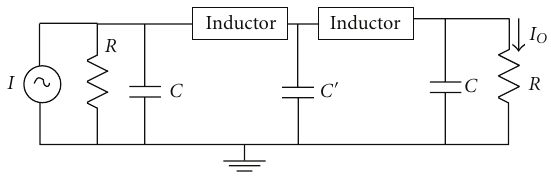
Figure 11: 5th order low pass filter.